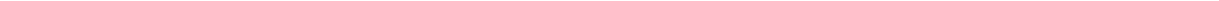
(Fig. 1b) that are linearly related to the amount of RNA injected (Fig. 1c). In the case of SARS-CoV-2 E protein 1 , these currents are sensitive to amantadine (Fig. 1d,